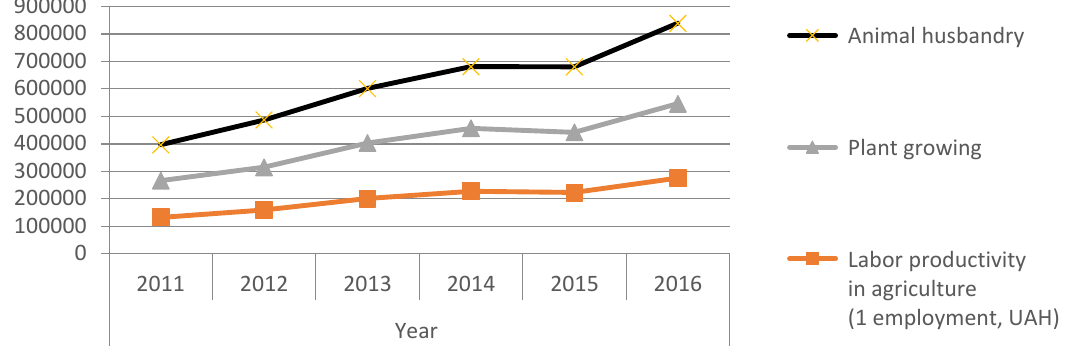
Figure 2. Labor productivity in the agrarian sector of